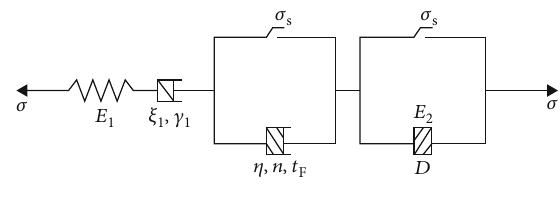
Figure 5: Creep damage model of